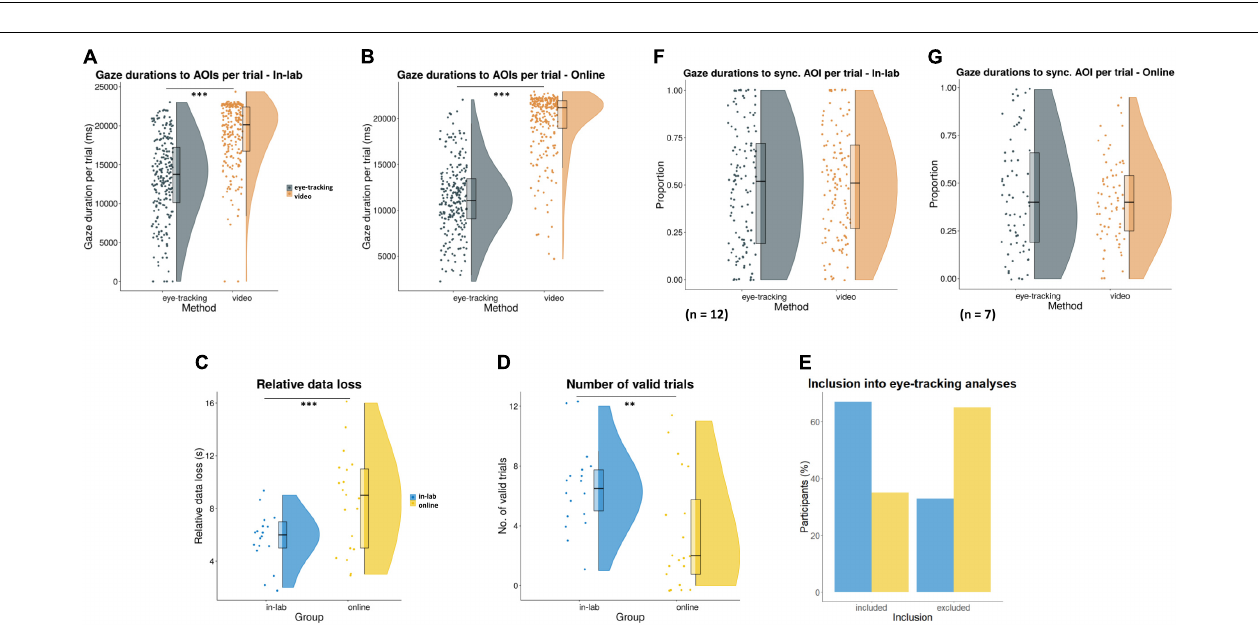
FIGURE 7 | Comparison of video data quality in-lab and online, based on (A) resolution; (B) frame rate per second (fps); and (C) brightness.